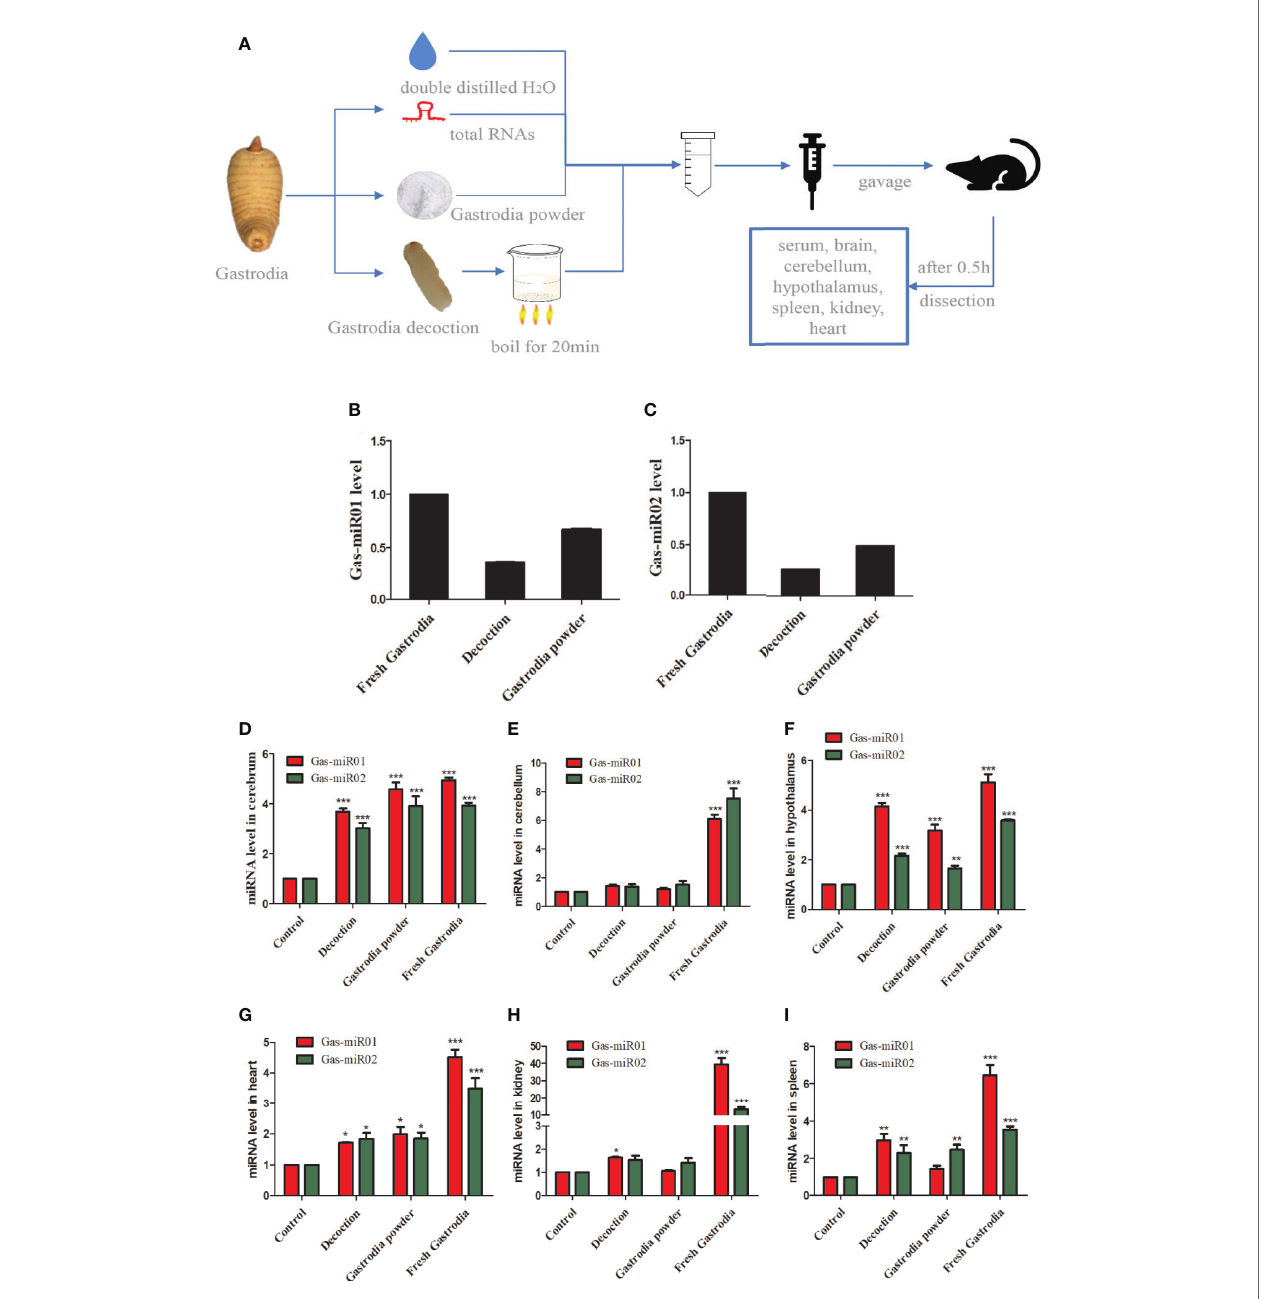
FIGURE 6 | Gas-miR01 and Gas-miR02 were detected in some tissues of mice by intragastric administration. (A) Flow chart of animal experiments. The levels of Gas-miR01 (B) and Gas-miR02 (C) in fresh G. elata tuber, Gastrodia decoction and Gastrodia powder. The fresh G. elata total RNAs, Gastrodia decoction and Gastrodia powder were gavaged and the levels of Gas-miR01 and Gas-miR02 in various tissues of mice were detected by qRT-PCR. The levels of Gas-miR01 and Gas-miR02 in mouse tissues. (D) cerebrum; (E) cerebellum; (F) hypothalamus; (G) heart; (H) kidney; (I) spleen. * p < 0.05; ** p < 0.01; *** p < 0.001 compared with the control group, n = 6. Values are the mean ±